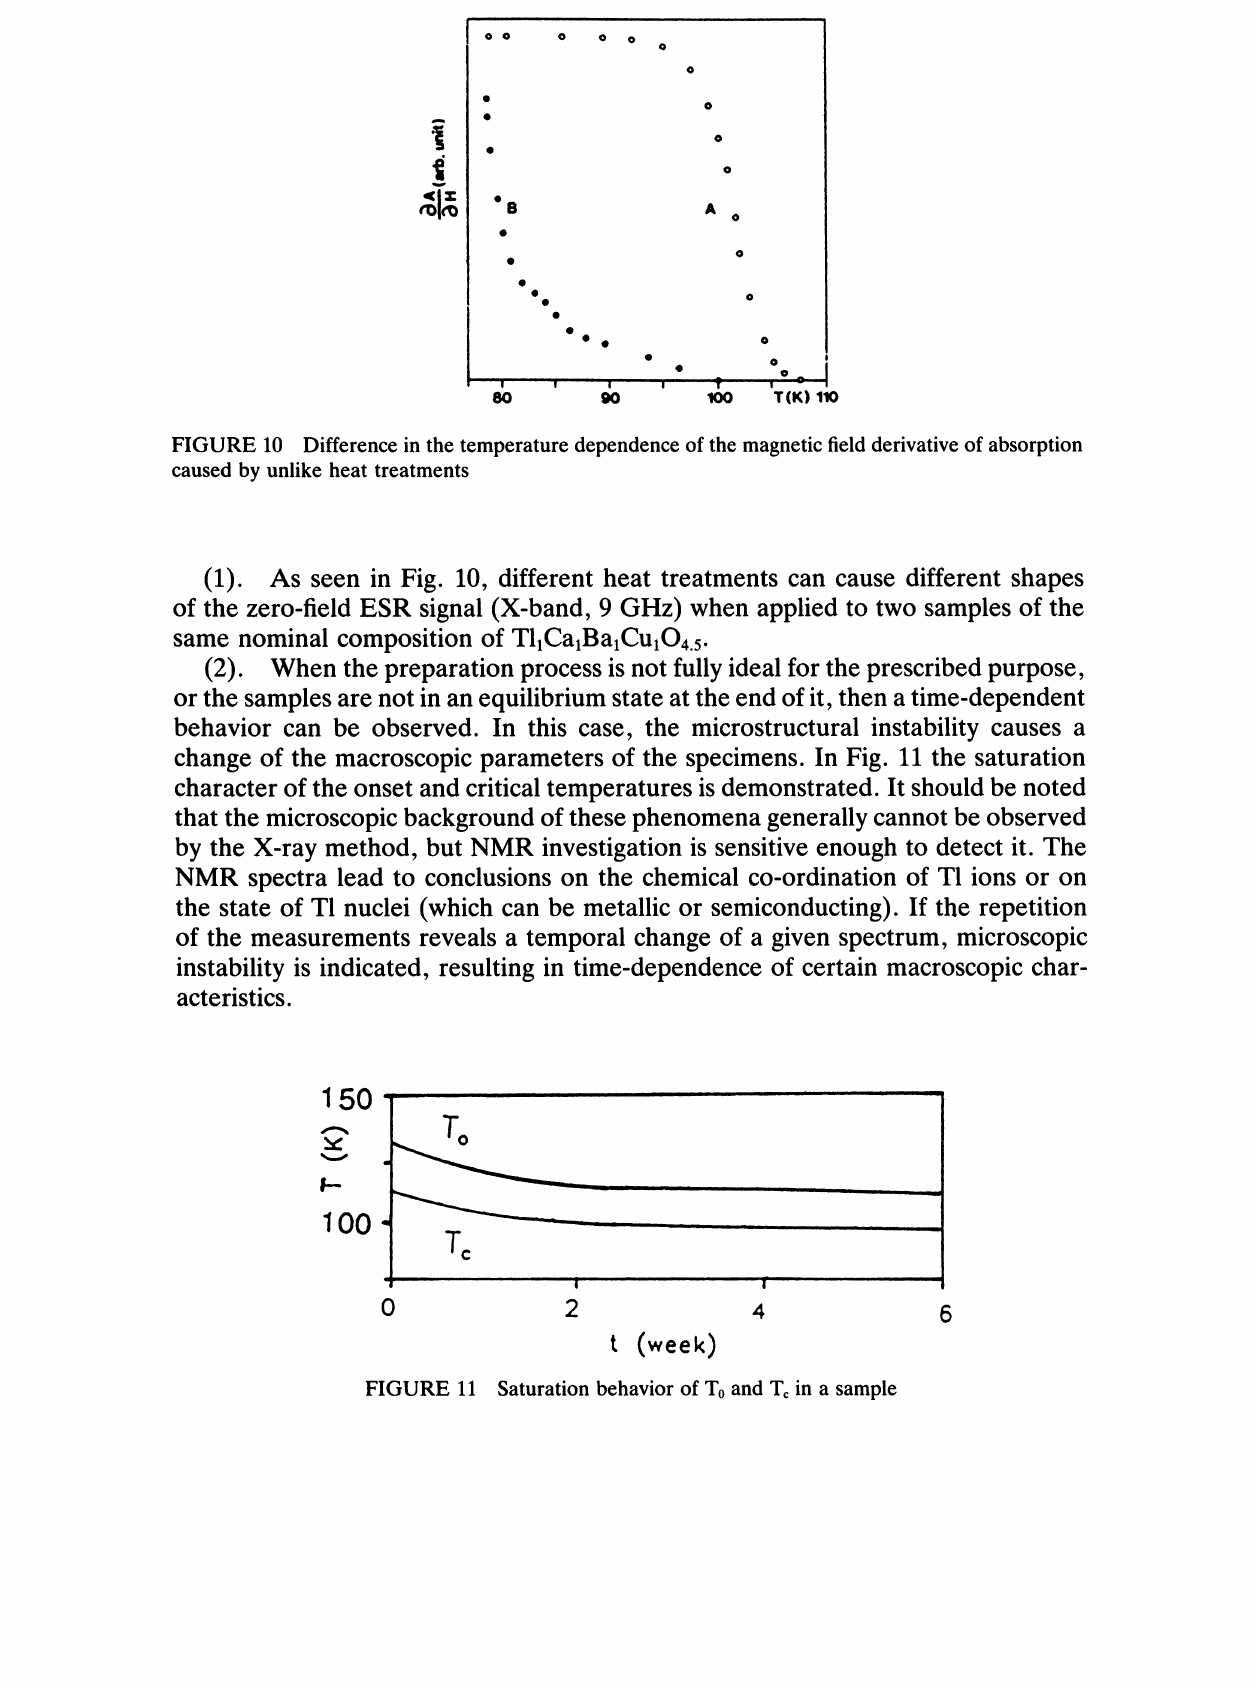
FIGURE 10 Difference in the temperature dependence of the magnetic field derivative of absorption caused by unlike heat treatments